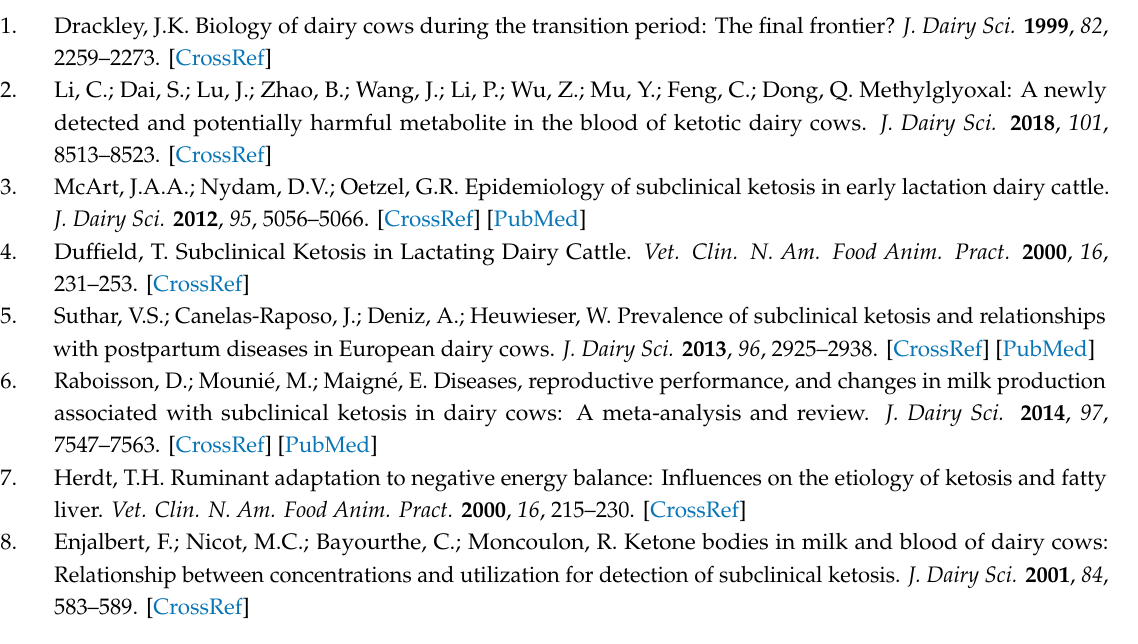
Figure S1: Validation of di ff erentially expressed genes by qPCR. Table S1: Characteristics of the Chinese Holstein dairy cows used in the study. Table S2: Ingredient and nutrient composition of the diets. Table S3: Primers used in this study for qPCR. Table S4: Mapping results of the transcriptome data. Table S5: The di ff erentially expressed genes identified in CK_vs_HC. Table S6: The di ff erentially expressed genes identified in HC_vs_PHC. Table S7: The di ff erentially expressed genes identified in CK_vs_PCK. Table S8: Biological process enriched by the DEGs in CK_vs_HC. Table S9: Biological process enriched by the DEGs in HC_vs_PHC. Table S10: Biological process enriched by the DEGs in